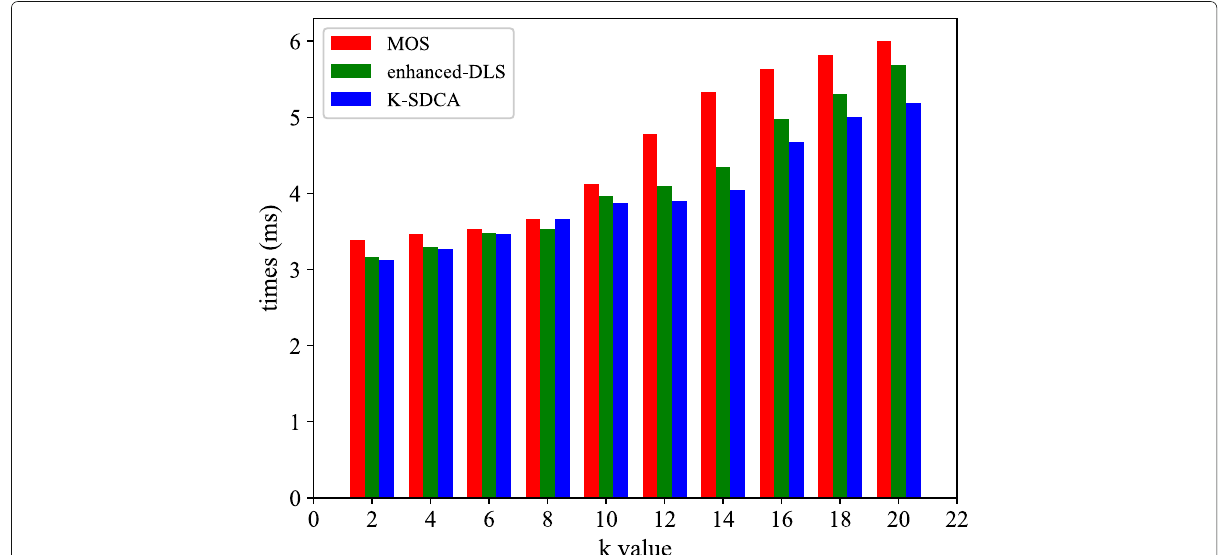
Fig. 11 Relationship between anonymous time and k value among different algorithms in sparsely populated regions. It indicates that the anonymous time of enhanced-DLS, K-SDCA, and MOS algorithms gradually increases with the raise of k . Under the conditions of the same k value, the K-SDCA algorithm is more efficient than the enhanced-DLS and MOS